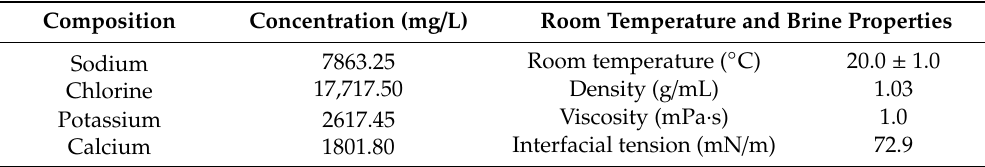
Figure 1. The scanning electron microscopy photos of samples: ( a ) #1-1; ( b ) #1-2.